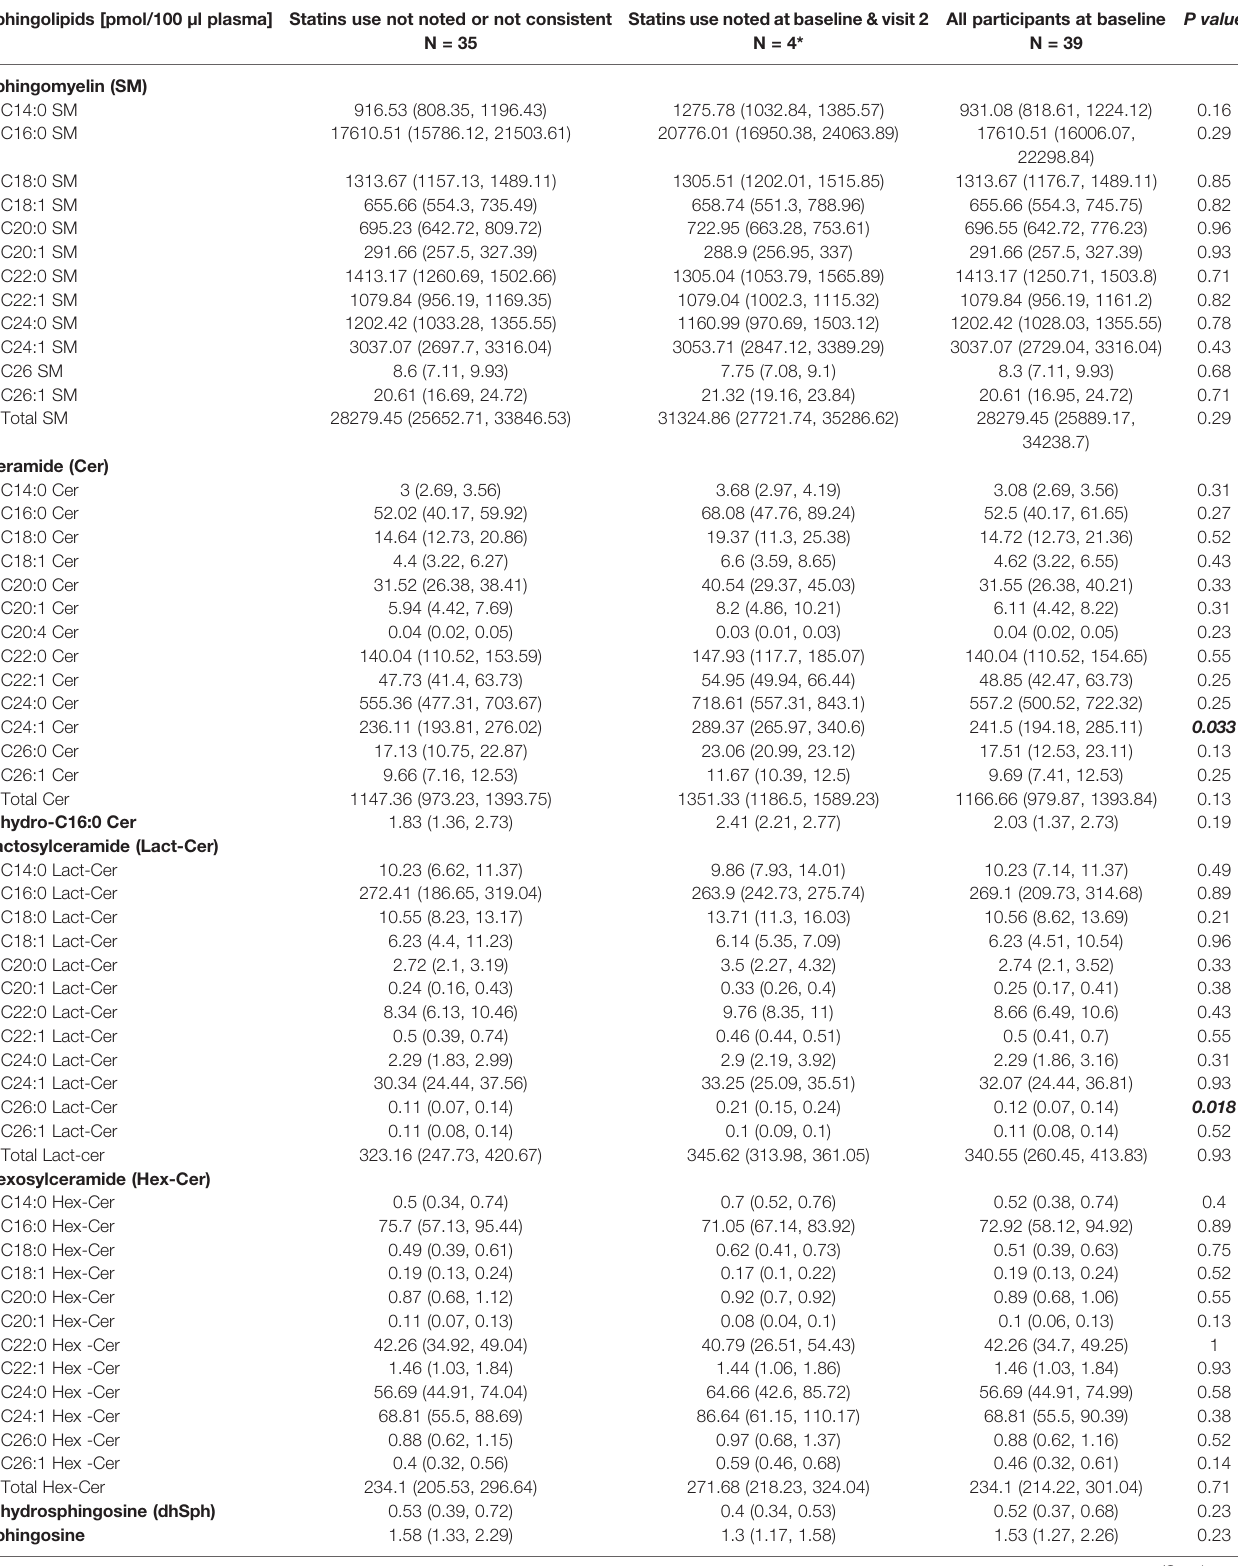
TABLE 4 | Comparisons in plasma sphingolipids between patients who did versus did not use statins consistently from visit 1 to visit 2. Sphingolipids [pmol/100 µl plasma] Statins use not noted or not consistent